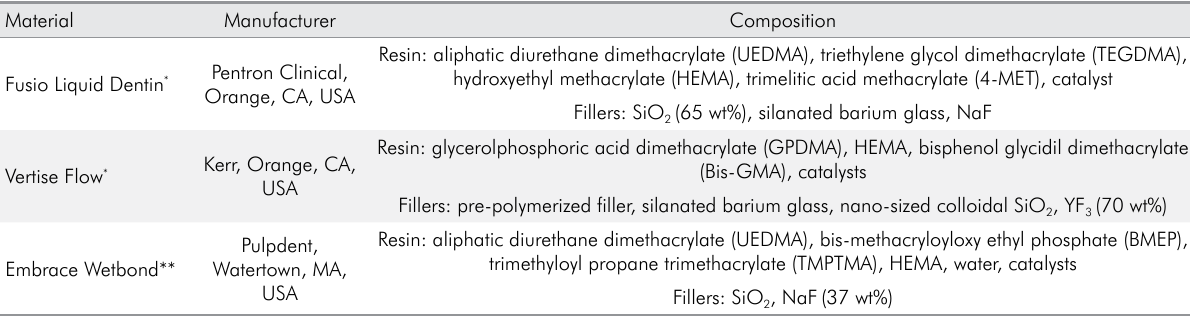
Table 1. Composition of commercially available self-adhesive composites.